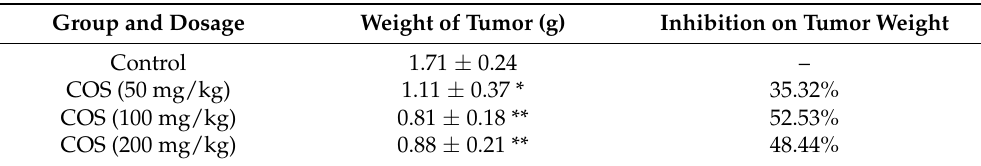
Table 1. Effects of COS on the Lewis tumor weight.